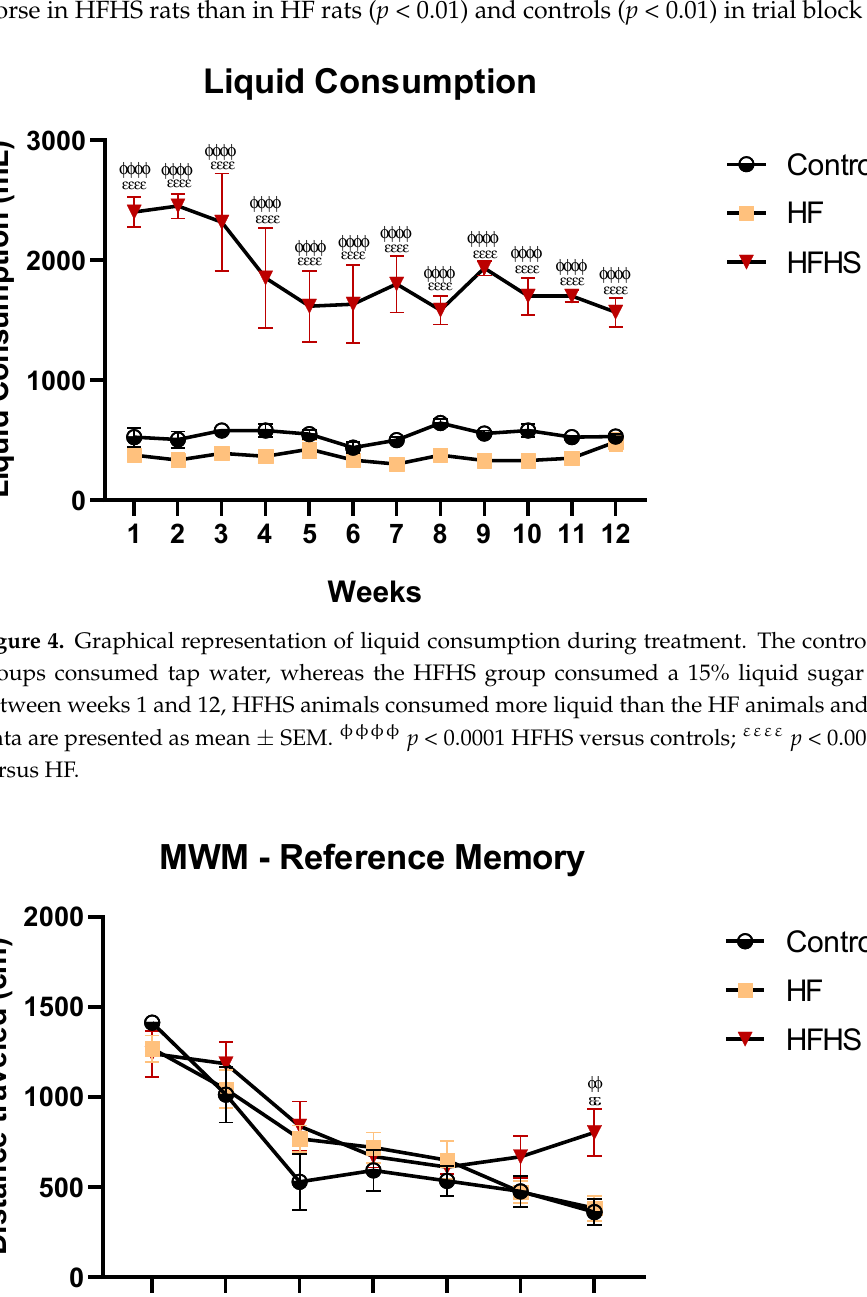
9 of 23 Figure 3. The graphic in (a) represents the food consumption during the twelve weeks of treatment. The histogram in (b) shows the Food Efficiency Ratio (FER) between the different groups. Data are presented as the mean ± SEM. ϕ p < 0.05; ϕϕ p < 0.01; ϕϕϕ p < 0.001; and ϕϕϕϕ p < 0.0001 HFHS versus